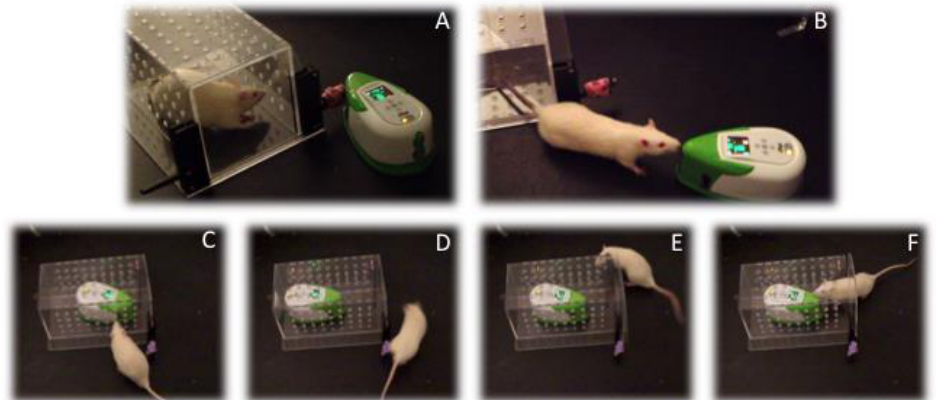
Figure 1 . Storyboard of a typical rat’s behavior with the helpful robot. A. The helpful robot pushes the lever to release a rat from the restrainer. B. A typical nose to “nose” check from the rat following robot opening the door. C. A rat viewing the helpful robot trapped in the restrainer. D. The rat moves directly from viewing the trapped robot to side of the restrainer where the lever is located. E. The rat presses the lever to open the door for the helpful robot (note the gaze of the rat towards the robot). F. The rat interacts with the robot immediately following door